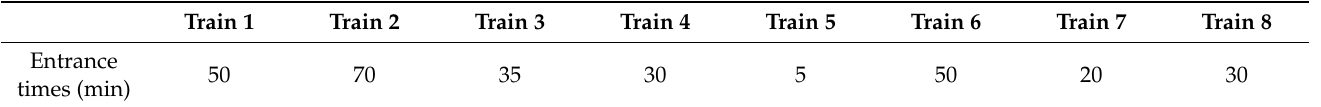
Table 16. Entrance times of the trains into the line in the 4 + 4 train instance with respect to time